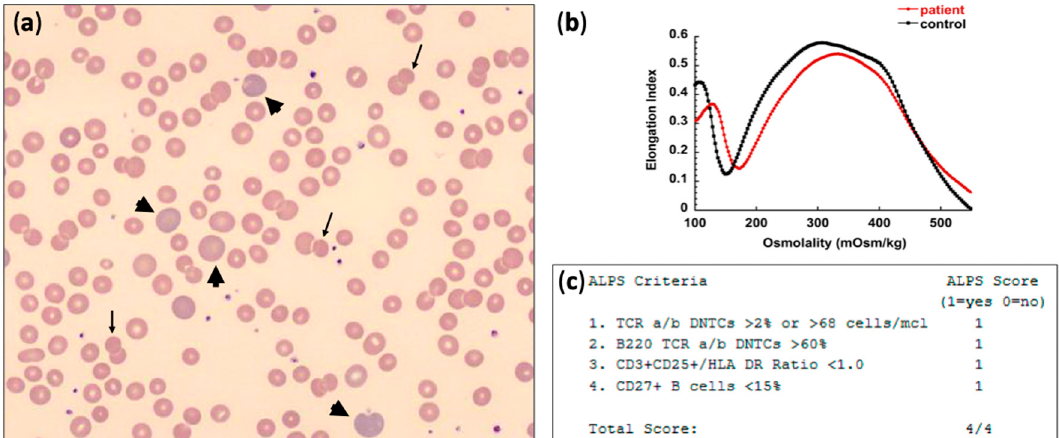
Figure 1. ( a ) Peripheral blood smear showing polychromasia (arrowheads) and occasional spherocytes and microspherocytes (arrows); ( b ) osmotic gradient ektacytometry in w-AIHA may be normal or compatible with acquired spherocytosis as in this case: showing mildly increased Omin and decreased EImax; ( c ) autoimmune lymphoproliferative syndromes (ALPS) screening panel positive for 4 out of 4 criteria.